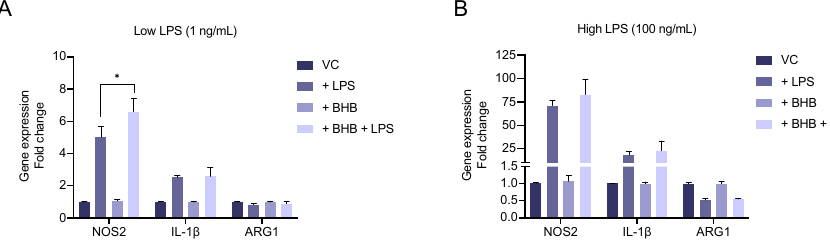
Figure4. E ff ectof β -hydroxybutyrate(BHB)onBV2polarisationafteractivationwithlipopolysaccharide Figure 4. Effect of β -hydroxybutyrate (BHB) on BV2 polarisation after activation with (LPS). Experiment was performed as indicated in Figure 2 using the unlabelled version for all metabolites. Gene expression of pro-inflammatory ( NOS2 and IL-1 β ) and anti-inflammatory ( ARG1 ) polarisation markers in response to low ( A ) or high ( B ) stimulation with LPS in the presence or absence of 5 mM BHB after 6 h. Bars represent mean +/ − SEM of n = 4 ( NOS2 ), n = 2 ( IL-1 β ) independent experiment ( IL-1 β ) independent experiment and n = 2 ( ARG1 ) biological replicates. Statistical significance was and n = 2 ( ARG1 ) biological replicates. Statistical significance was assessed by paired two-way ANOVA for individual genes followed by Sidak’s test (-BHB vs. + BHB within treatment class) (( A ) NOS2 : LPS p < 0.01, BHB p < 0.01, LPS × BHB p < 0.01; ( B ) NOS2 : LPS p < 0.01, BHB n.s., LPS × BHB n.s.). Statistical significance is denoted as * p <